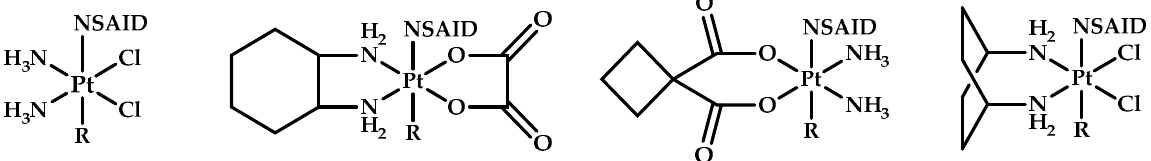
Figure 1. General structures of cisplatin-based, oxaliplatin-based, carboplatin-based, and kiteplatin-based Pt(IV) prodrugs with non-steroidal anti-inflammatory drugs (NSAIDs) as axial lig- and(s).